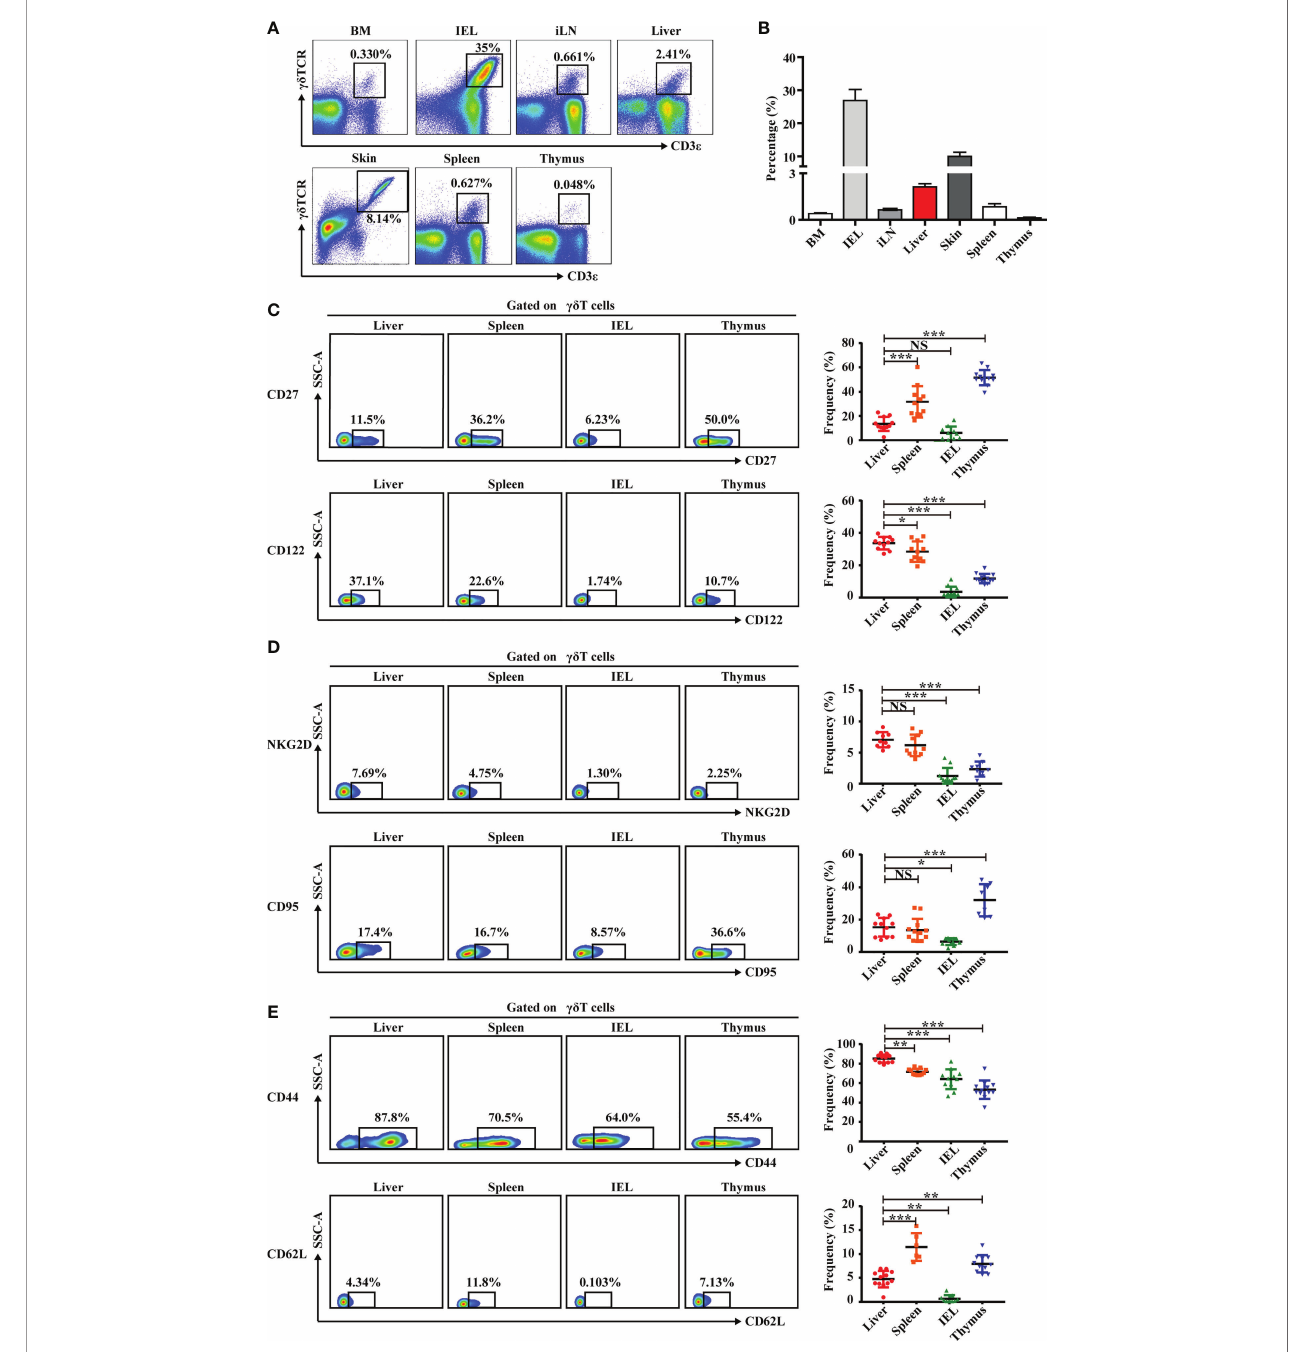
FIGURE 1 | Liver contains abundant gd T cells that exhibit a unique phenotype. (A) Representative FACS plots of gd T cells (CD3 + TCR gd + ) in BM, IEL, iLN, liver, skin, spleen, and thymus of C57BL/6J mice. (B) Statistical analysis of gd T-cell percentages in the indicated organs. (C – E) Representative FACS plots (left) and percentage (right) of gd T surface markers on cells in indicated organs. Each dot represents a mouse. Data are shown as mean ± SEM. (* p < 0.05; ** p < 0.01; *** p < 0.001. One- way ANOVA with post-hoc test). BM, bone marrow; IEL, intraepithelial lymphocyte; iLN, inguinal lymph node; NS, not signi fi